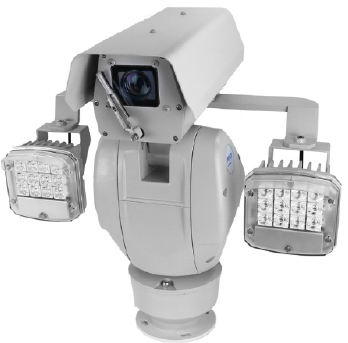
Figure 2. Pelco Esprit ® Enhanced Series camera.